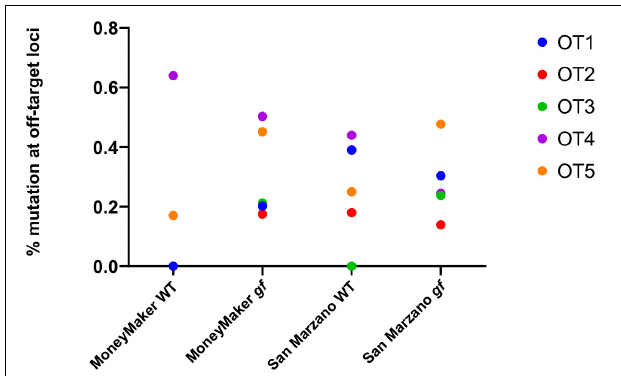
FIGURE 3 | Frequencies of mutation at putative off-target loci. Five putative off-target loci were analyzed for CRISPR-induced mutations. For each population and each putative off-target (OT), variation is expressed as the means of mutation rates for each plant, these being calculated as the % of mutated reads for each individual. All detected mutations are SNPs, no indels were reported. The combined mutation rates for all five OTs were compared between wild-type and edited plants, and no significant differences were found (ANOVA, p = 0.66).